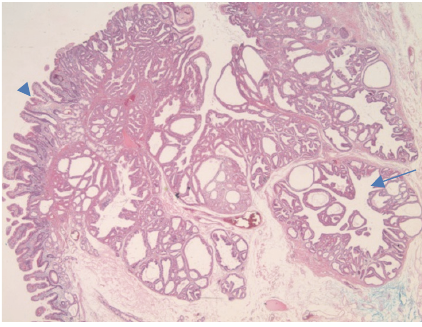
Figure 2: Low power view of the PGA (arrow) arising from the duodenum with normal villous mucosa (arrowhead).